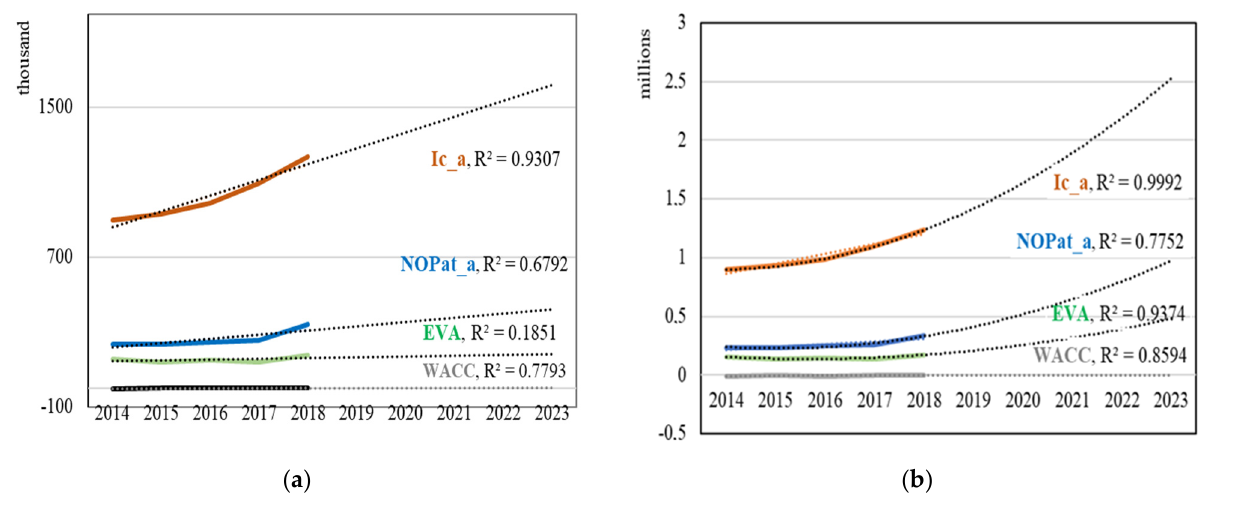
Figure 2. Trend testing. ( a ) Linear trend lines; ( b ) Polynomial trend lines. Source: Authors own representation.